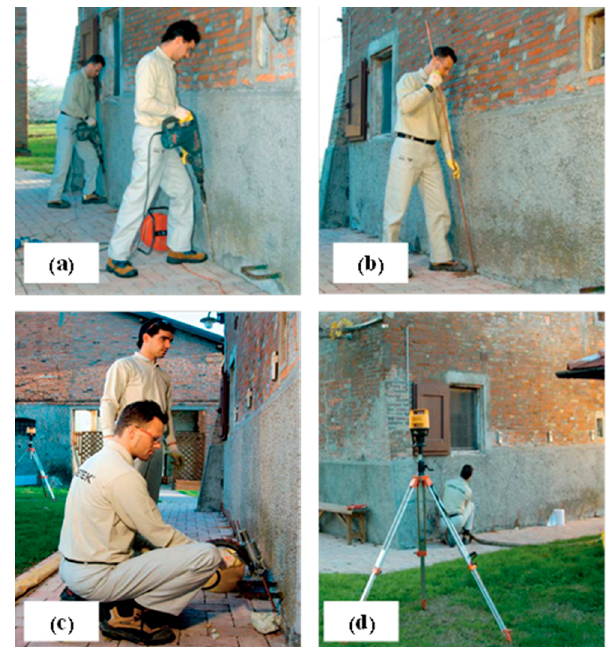
Figure 3. Stages of the process: ( a ) Drilling, ( b ) Introduction of the injection pipes, ( c ) resin injection head, ( d ) laser level to control lifting.